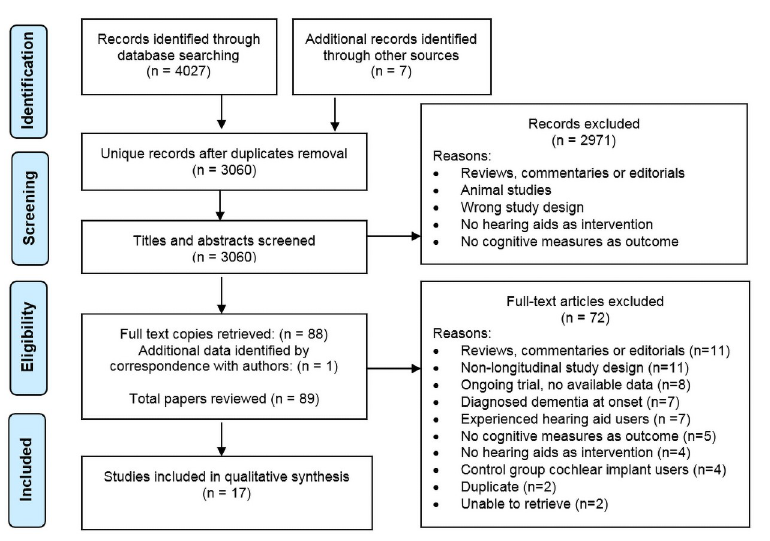
Fig 1. Flow chart of article selection